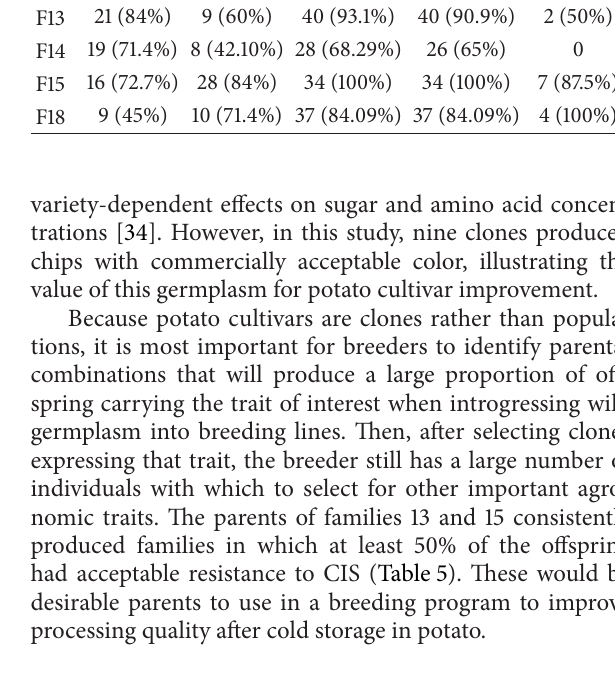
Table 4: Mean chip score of five families in five cold storage trials. Chip score ratings were based on a scale of 1 (light) to 10 (dark).